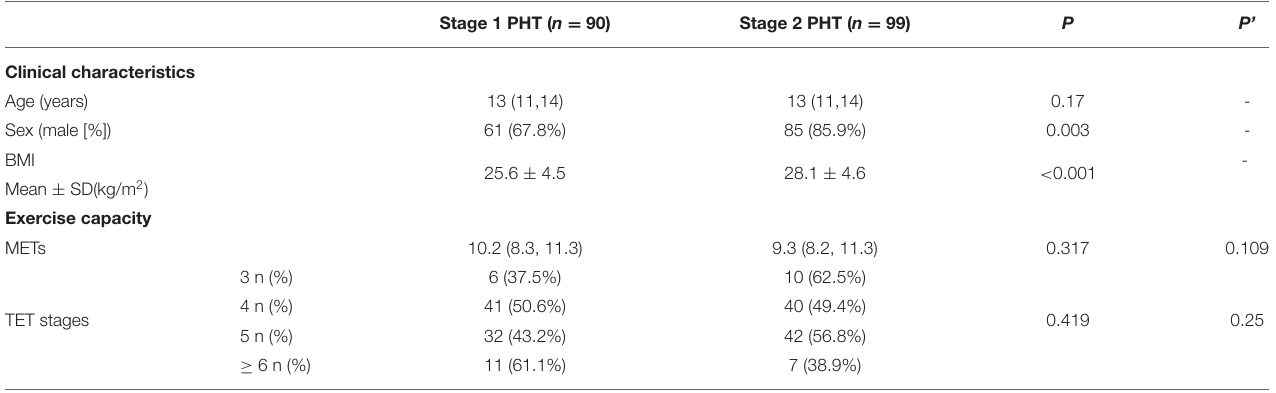
TABLE 2 | Comparison of exercise capacity between different hypertension stages.